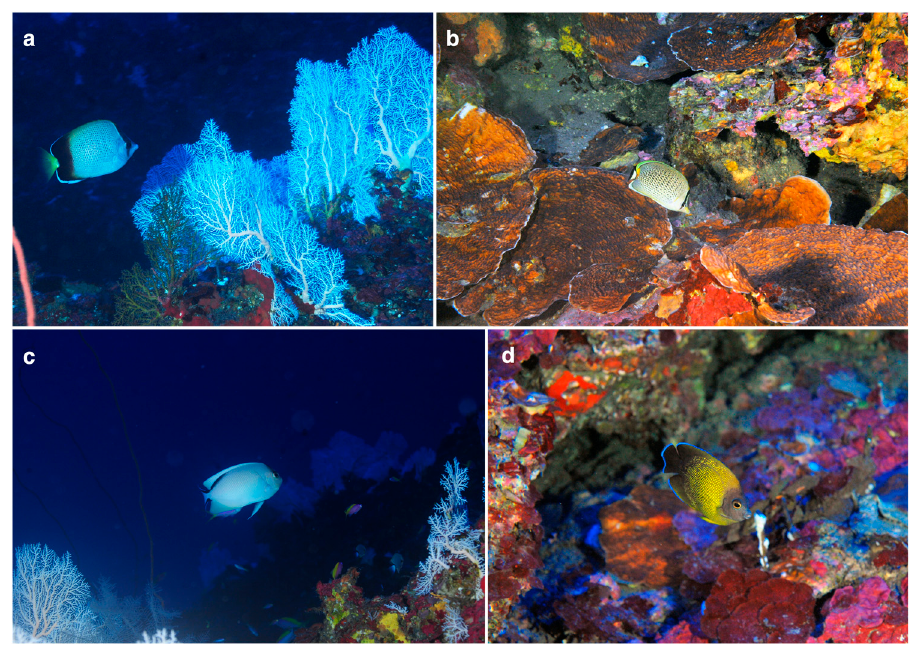
Figure 2. Some of the fishes associated to Leptoseris spp. and S. flabelliformis . ( a ) Chaetodon dolosus , ( b ) C. guttatissimus , ( c ) Genicanthus caudovittatus ♀ with Pseudanthias evansi in the background, and ( d ) a rare endemic species angelfish species Apolemichthys guezei .